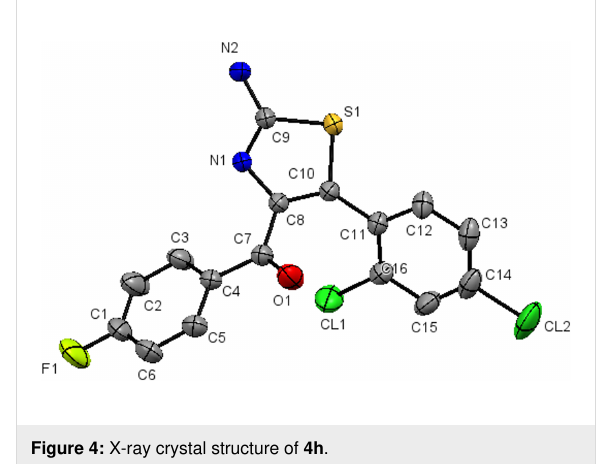
Figure 4: X-ray crystal structure of 4h